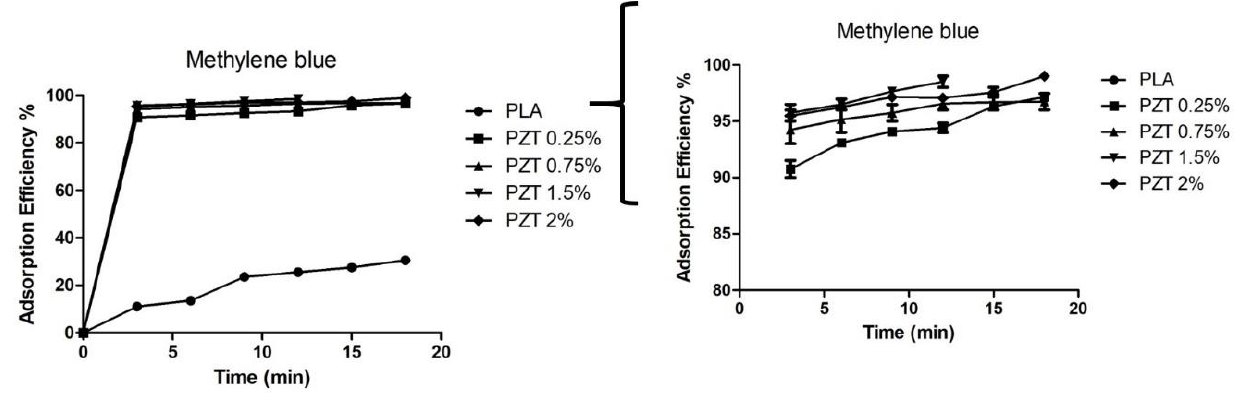
Figure 6. The adsorption efficiency of PLA and nanocomposite PZT at different concentrations (MB concentration = 200 mg/L; nanocomposite content = 20 mg/20 mL; T = 25 °C and t = 18 min). The second figure is the same, at a scale of 80 to 100% adsorption efficiency.